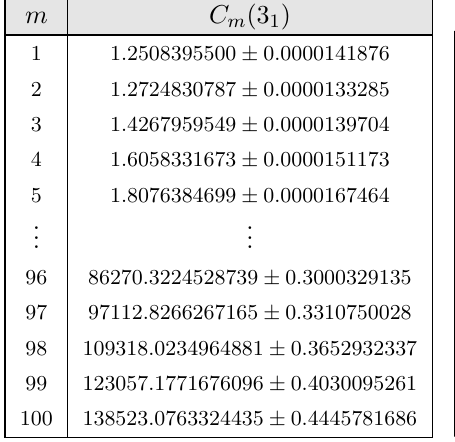
Table 2. Values of C m (3 1 ) . Figure 4. Variation of ln C m (3 1 ) with m .